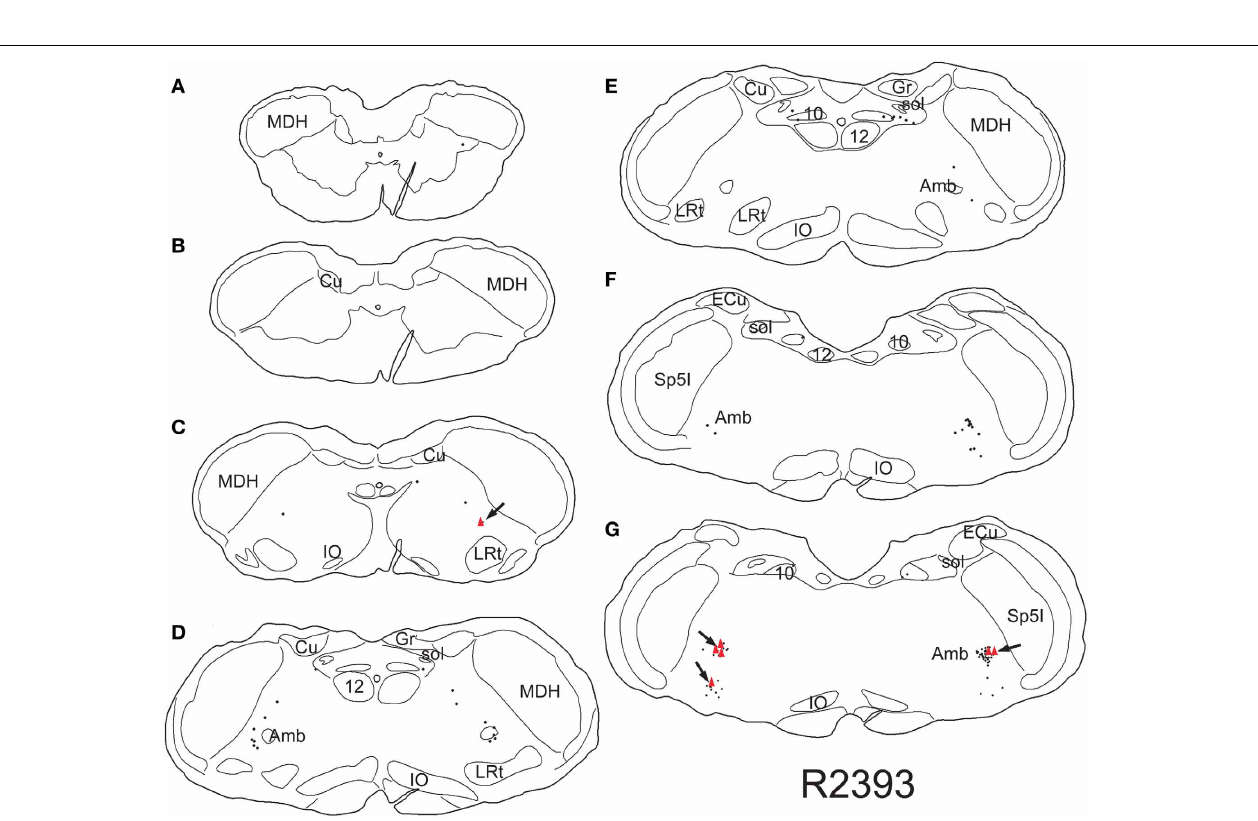
FIGURE 2 | Line drawings illustrating neurons labeled singly with CTB (small dots) or doubly with CTB and cFos (red triangles) in a rat trained to dive underwater and receiving a pericardial injection of CTB. While single labeled neurons were found mostly in the reticular formation, especially in the external formation of the nucleus ambiguus, most double-labeled neurons are found in the rostral ventral lateral medulla